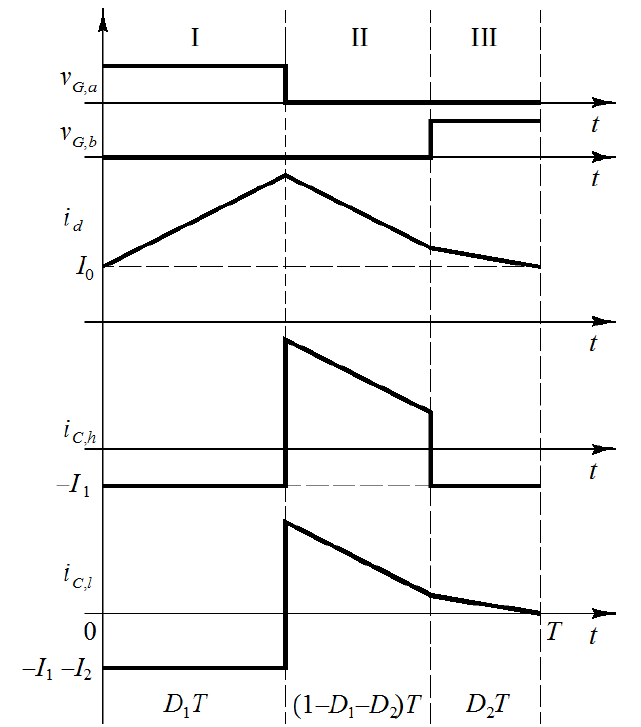
Figure 7. Key waveforms concerning the operation stages of the proposed